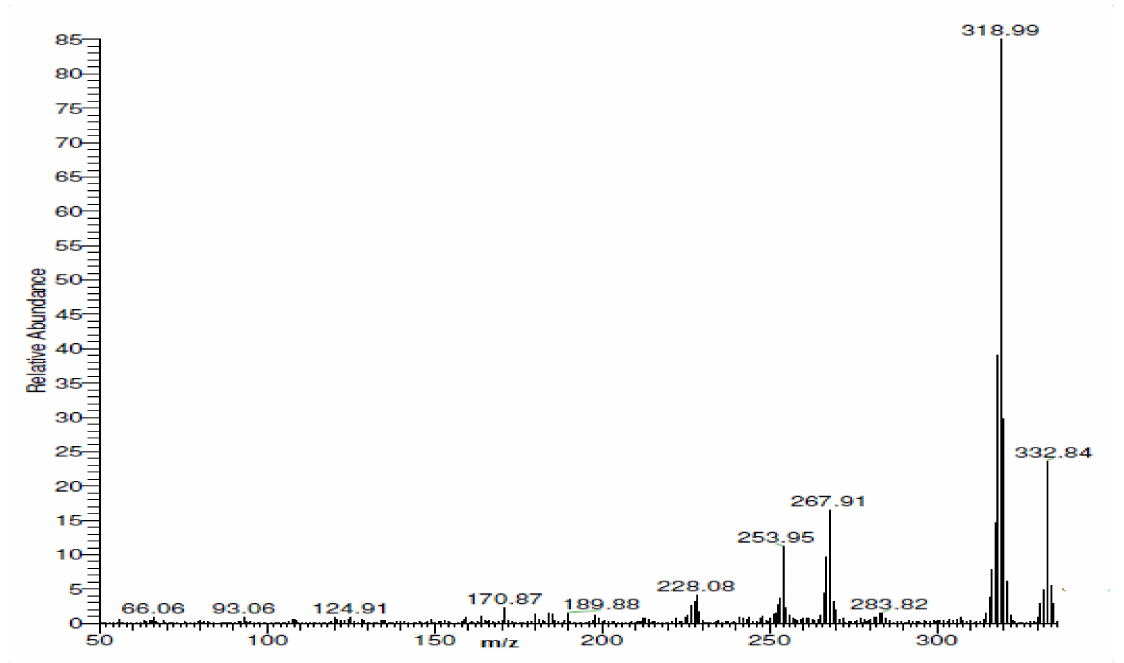
Figure 1. Mass spectrum of acetyl ferrocene imine